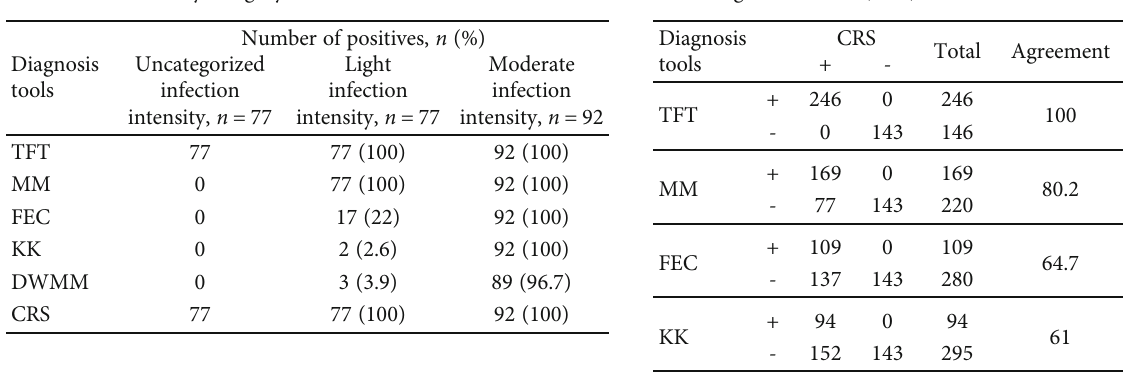
Table 4: Degree of agreement of hookworm diagnosis techniques with the gold standard